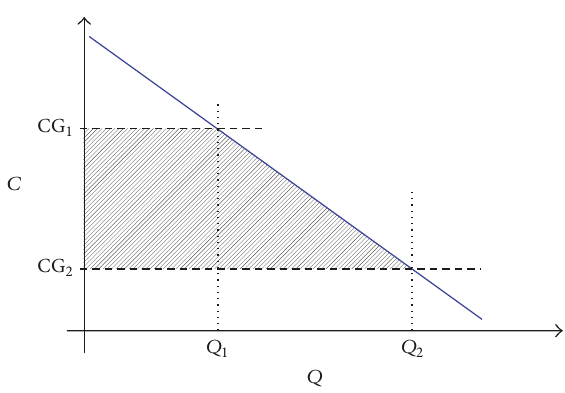
Figure 1: Representation of the Rule of Half (our